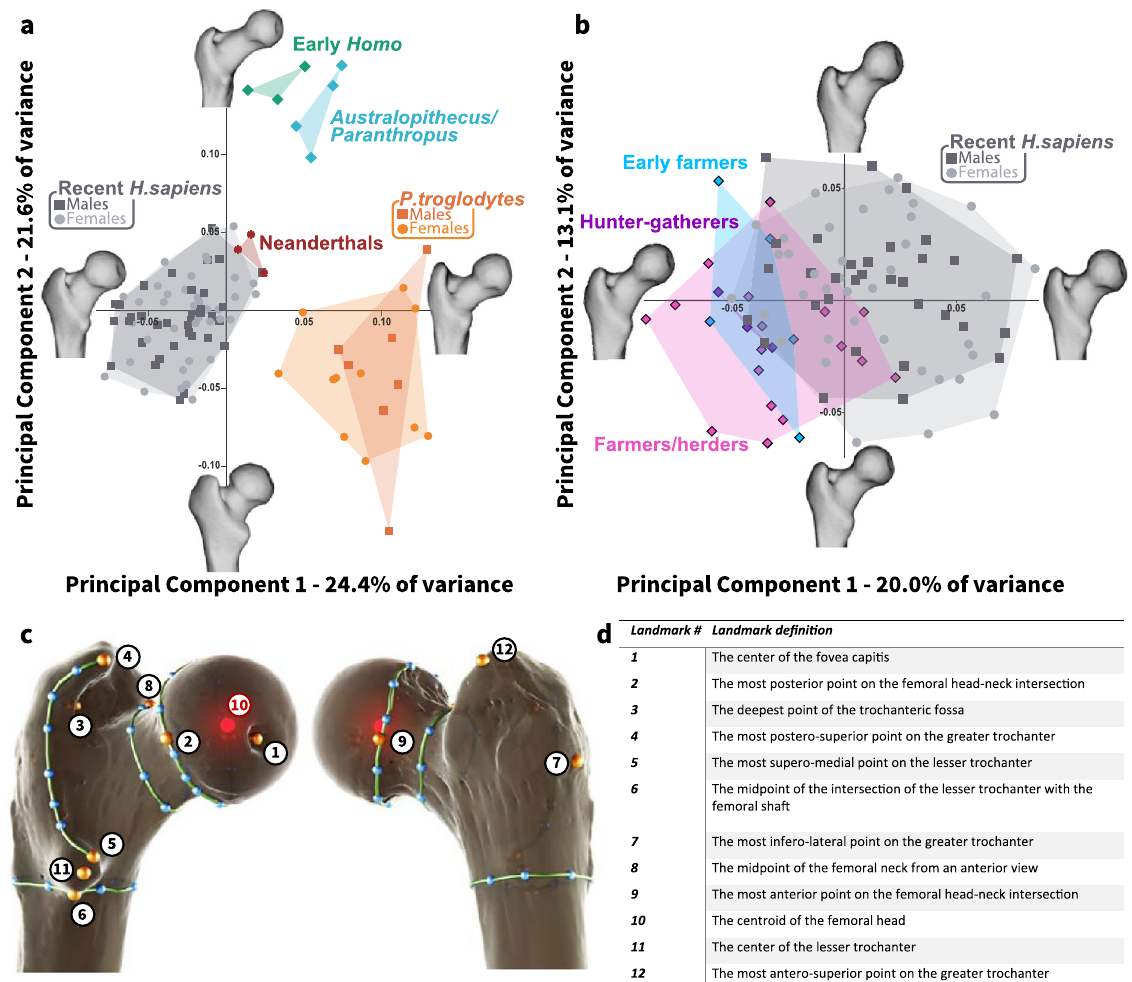
Fig. 1 Proximal femoral shape variance among Pan troglodytes, early hominin, and modern human groups. a Principal component analysis (PCA) plot in shape-space for the proximal femur of Pan troglodytes (orange), Australopithecus / Paranthropus (light blue), early Homo (light green), Neanderthals (red), and recent humans (gray; age 18 – 45 years). PC1 (explains 24.4% of the shape variance) distinguishes between Pan troglodytes ( N = 18) and recent humans ( N = 74); early hominins ( N = 4) and early Homo ( N = 3) fell in between and can be distinguished from other groups along PC2 (explains 21.6% of the shape variance). Neanderthals are in the upper variation of recent humans along both PC1 and PC2. b PCA in shape-space for the proximal femur among populations with different subsistence strategies: Hunter-gatherers ( N = 3) – Epi-Paleolithic (purple), early farmers ( N = 5) – Pre-Pottery Neolithic (blue), pastoralists ( N = 17) – Chalcolithic (pink), and recent humans (gray; 18 – 45 years old, N = 70). A gradient of change in the proximal femoral shape variance over time is evident along PC1. Details regarding the sample included in the study appear in Tables S1 and S2. c The positions of landmarks (orange, numbered dots), curves (green lines), and semi-landmarks (blue dots) on the proximal femora. d De fi nition of the landmarks ’ position (de fi nitions of the curves ’ position are presented in Table